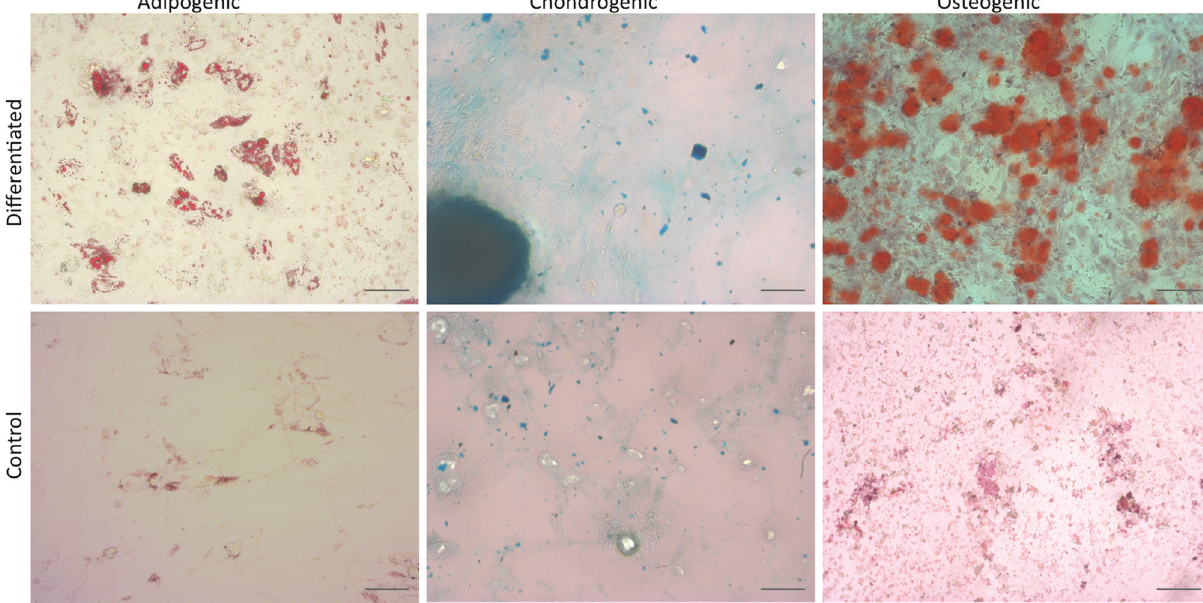
Figure 3 - Differentiation potential of adipose-derived MSCs. Representative results show trilineage differentiation potential of cultures. Scale bar = 50 (cid:2)